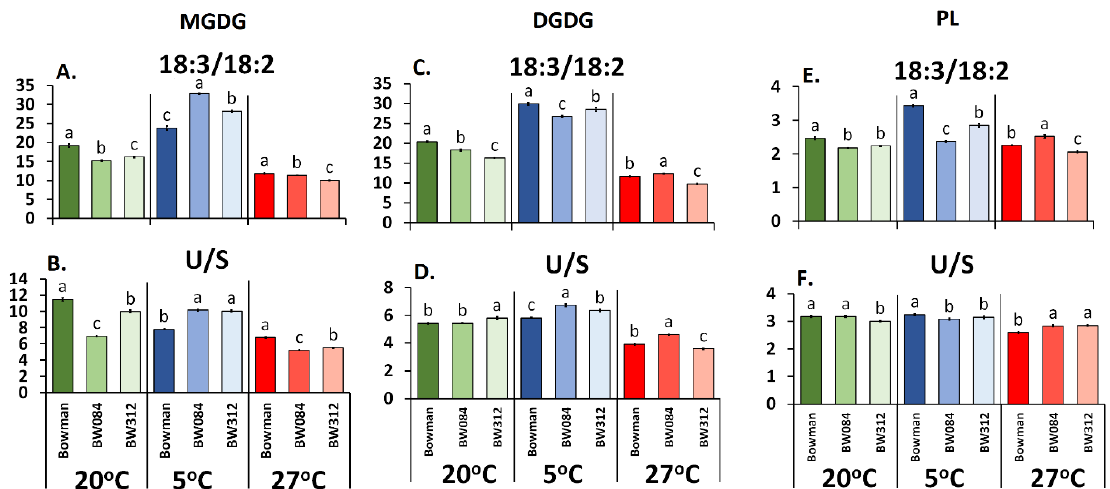
Figure 1. The ratio of fatty acid 18:3 to 18:2 (18:3 / 18:2) and unsaturated fatty acids to saturated fatty acids (U / S) for the specific lipid fractions (galactolipids and phospholipids) that were isolated from the leaves of the barley WT Bowman, mutant BW084 and mutant BW312 cultured at 20 ◦ C and then acclimated at 5 ◦ C and 27 ◦ C. Any significant di ff erences between WT Bowman and its mutants (Duncan test, p ≤ 0.05) for each temperature are indicated by different letters. ( A , B ) Fraction of galactolipids (MGDG); ( C , D ) Fraction of galactolipids (DGDG); ( E , F ) Fraction of phospholipids (PL)